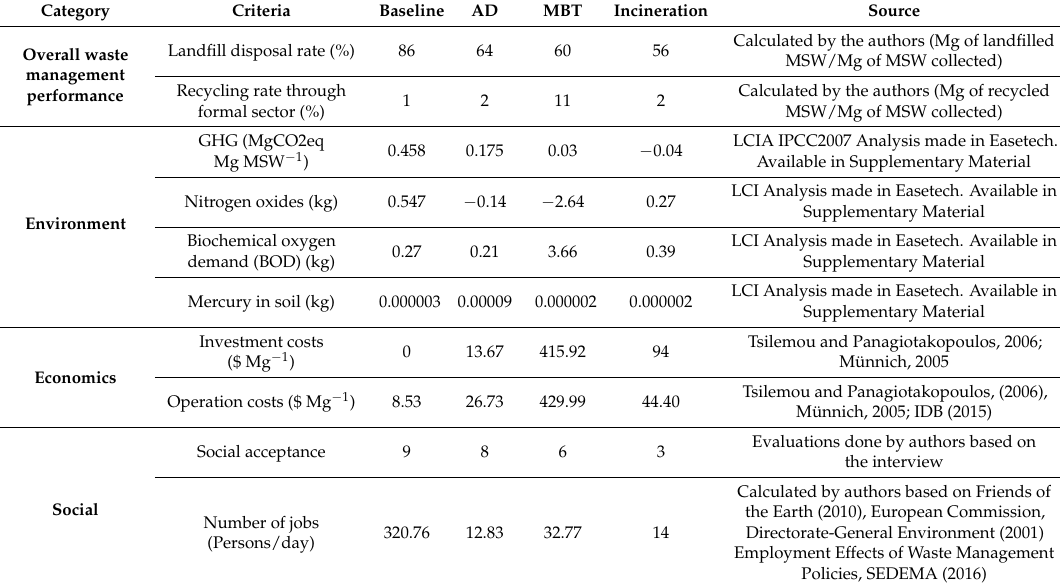
Table 3. Evaluation of